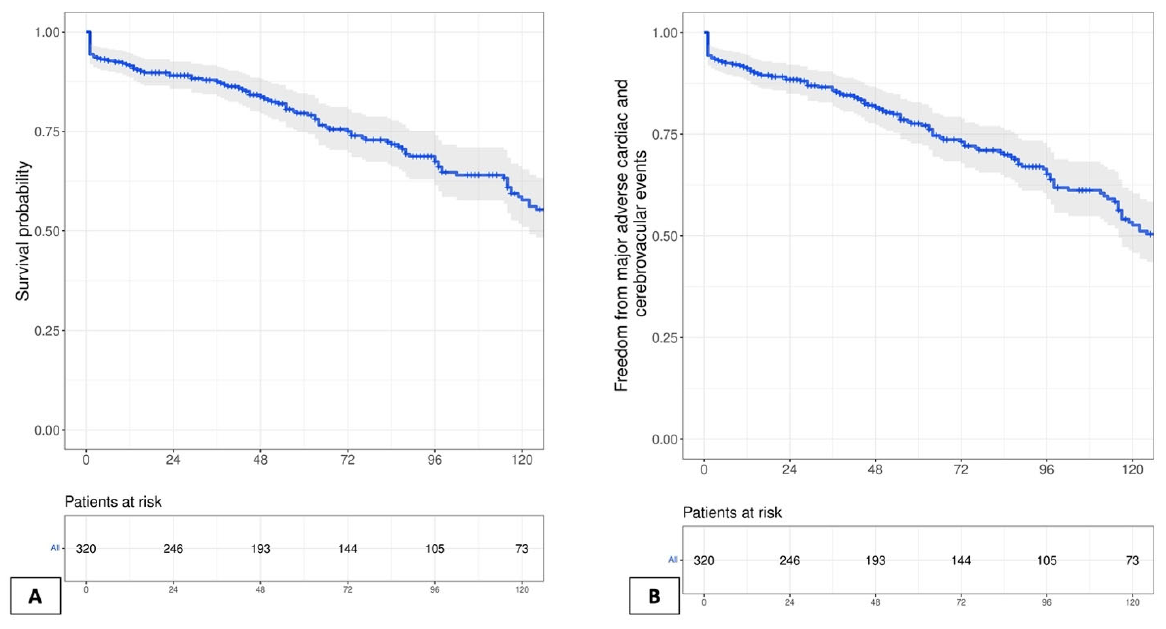
Figure 3. Long-term clinical outcomes presented as: ( A ) Kaplan–Meier curve showing estimated cumulative survival, ( B ) Kaplan–Meier curve showing freedom from MACCE.